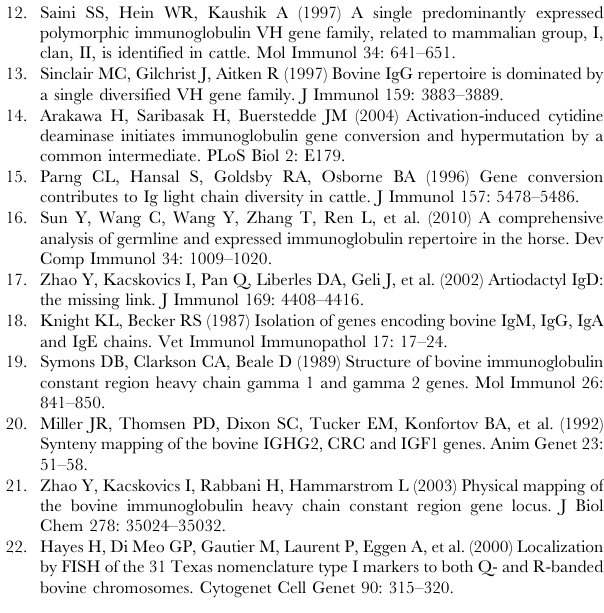
Table S1 Genomic annotation of the bovine immuno- globulin heavy-chain locus. For a functional gene (F), the complete coding sequence, octamer motif, TATA box, splicing signals or recombination signal sequences (RSS), and poly A motif were identified. Putative functional genes ((F)) lacked some of the described parts due to end of the contig or N’s introduced into gaps for example. ORFs are classified by alterations in the splicing signals, RSS or regulatory elements. The extension (ORF) describes fully functional genes in putative orphons.